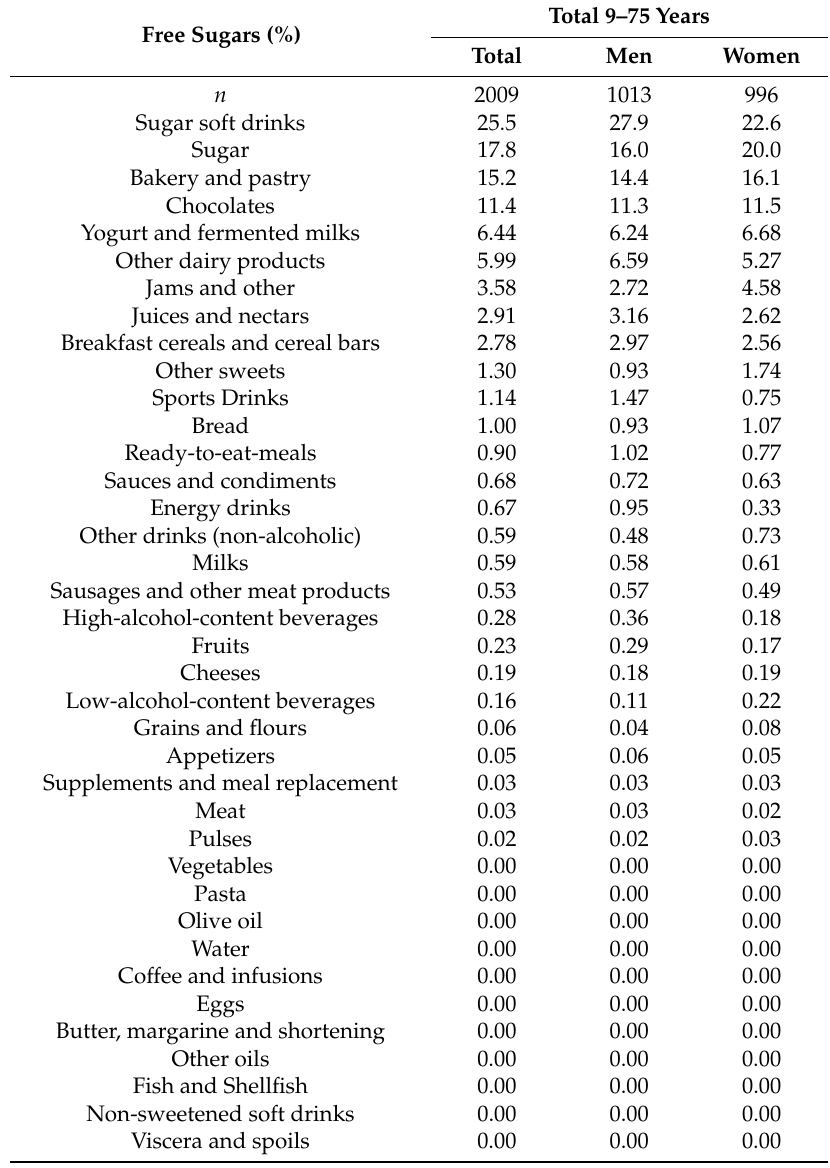
Table 6. Dietary sources of free sugars (%) from food and beverage subgroups in the ANIBES Study Spanish population aged 9 to 75